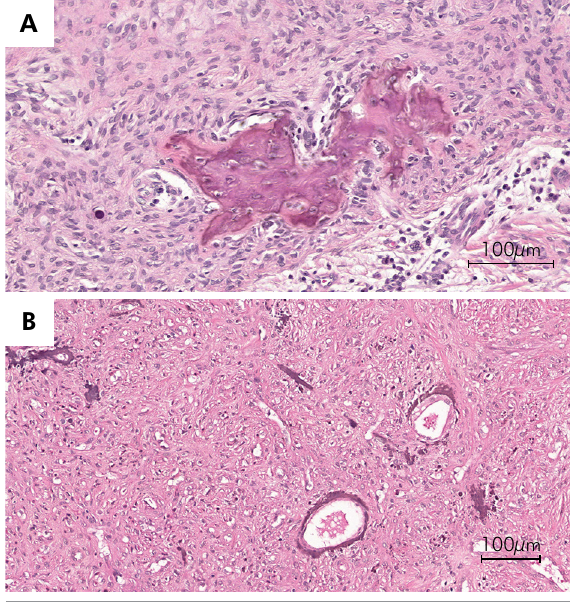
Figure 1. Clinical photograph of cases that occurred in the gingiva (1A) and alveolar ridge